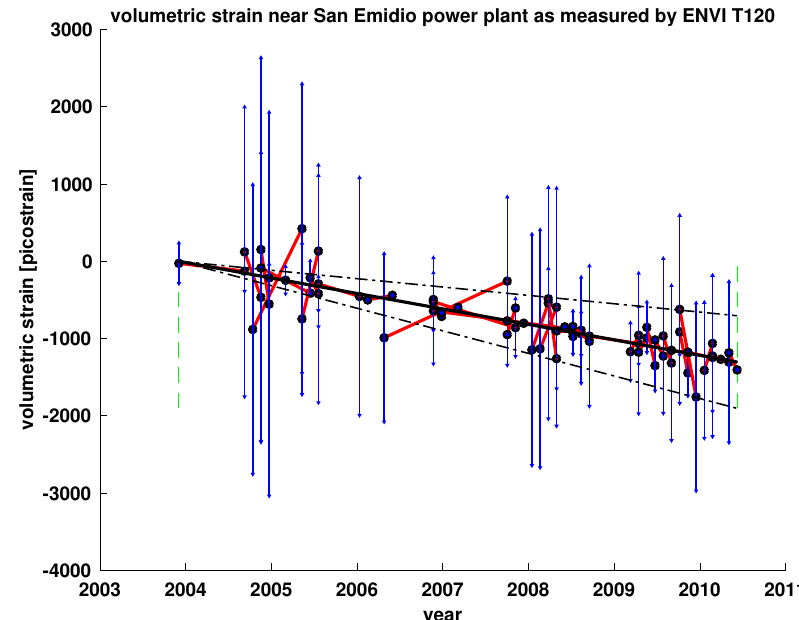
Figure A9. Cumulative strain near the San Emidio power plant as derived from temporal adjustment of mean strain rate values near the plant as measured by the ENVI T120 MST data set. Plotting conventions as in Figure 6.